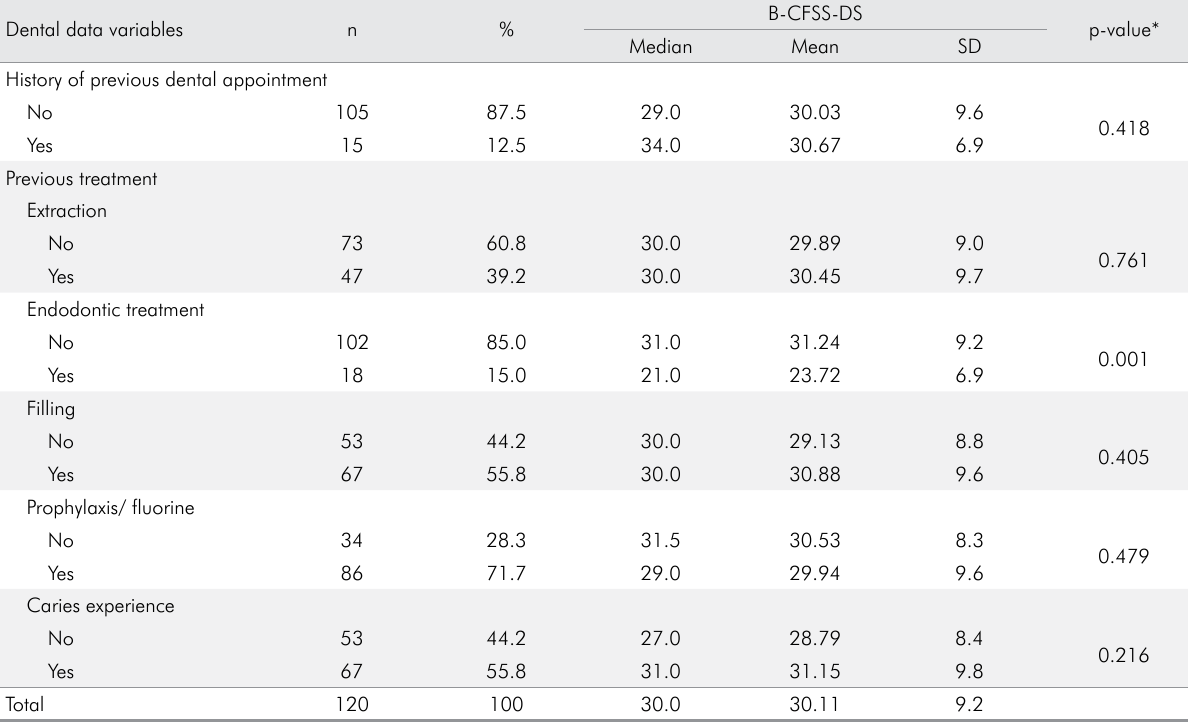
Table 5. Dental data comparisons according to B-CFSS-DS scores. Dental data